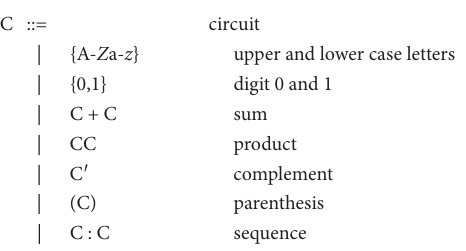
Figure 4: Grammar of the input description language.